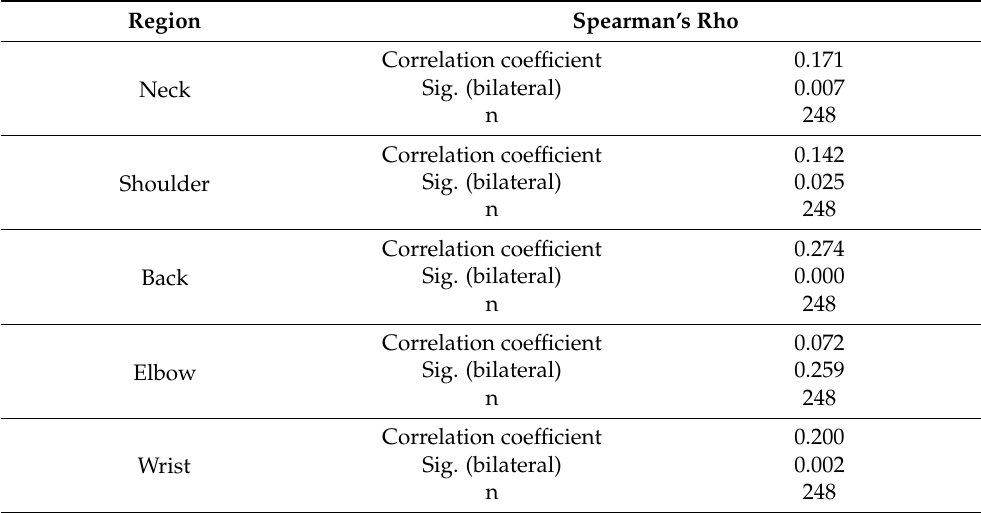
Table 3. Correlation between Mobile Device Dependency and